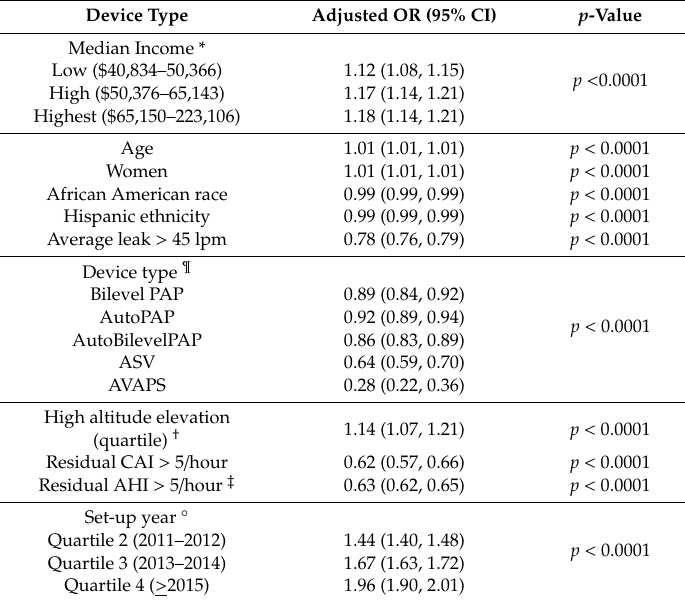
Table 5. Multivariate logistic regression of adherence to PAP